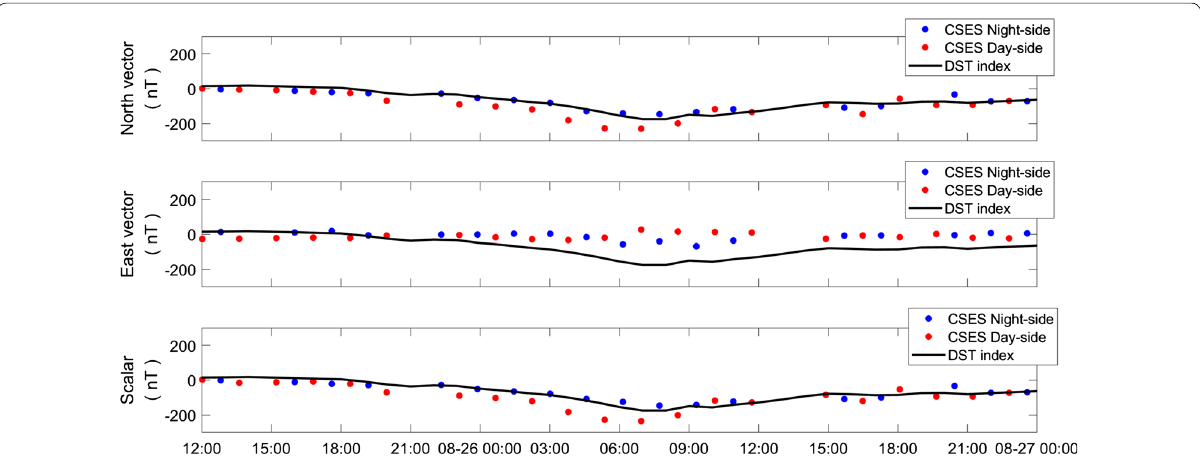
Fig. 22 Northward, eastward component and scalar magnitude variations are observed during the magnetic storm in August, 2018